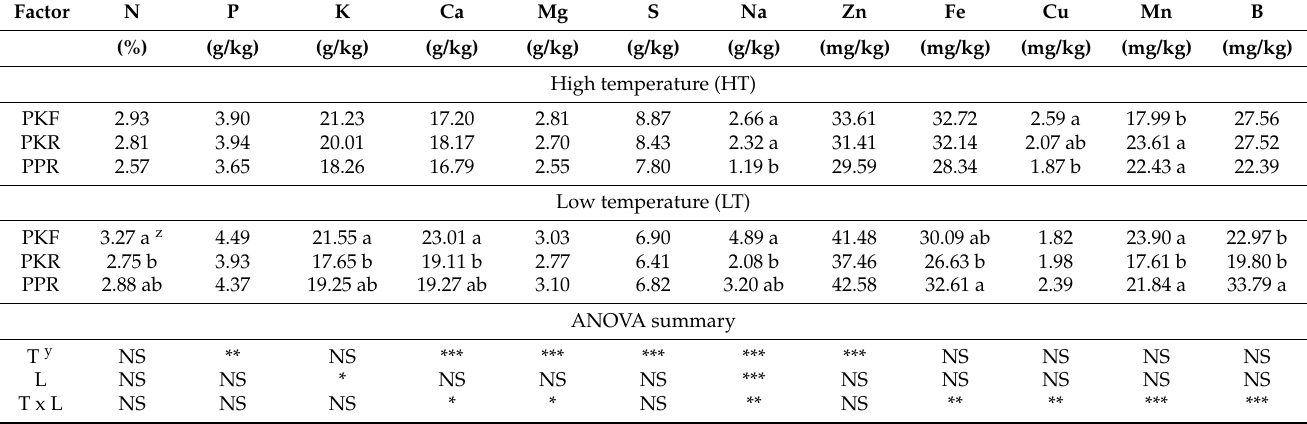
Table 3. Macronutrients of nitrogen (N), phosphorus (P), potassium (K), calcium (Ca), magnesium (Mg), and sulfur (S); and micronutrients of sodium (Na), zinc (Zn), iron (Fe), copper (Cu), manganese (Mn), and boron (B) of ‘Petite Star’ pak choy ( Brassica rapa subsp. Chinensis ) plants grown under two temperatures: high and low (HT, LT) and three light spectra: PKF (blue, 8%, green 15%, red 72%,